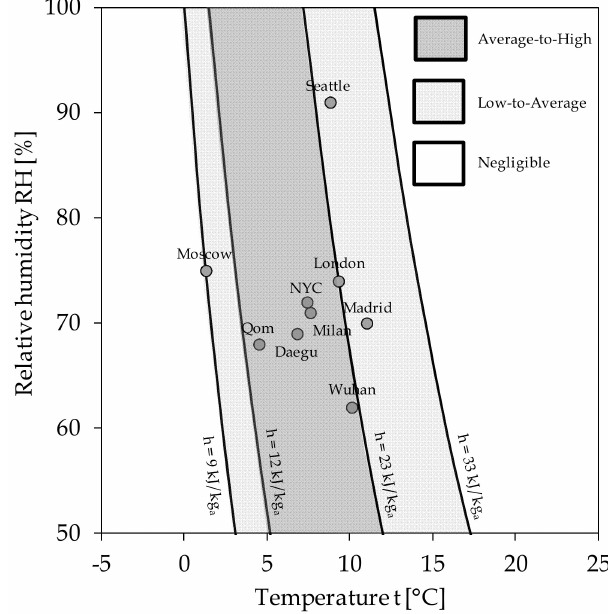
Figure 5. Verification of the cluster of ten global cities over the proposed chart of SVR